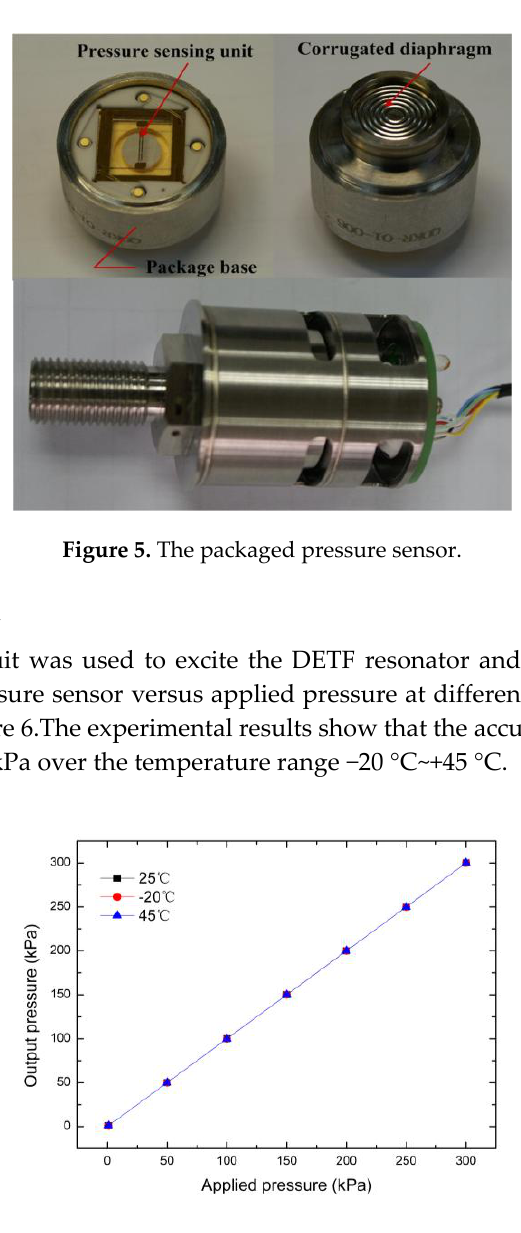
Figure 6. Output of the pressure sensor versus applied pressure at different temperature with RS-485